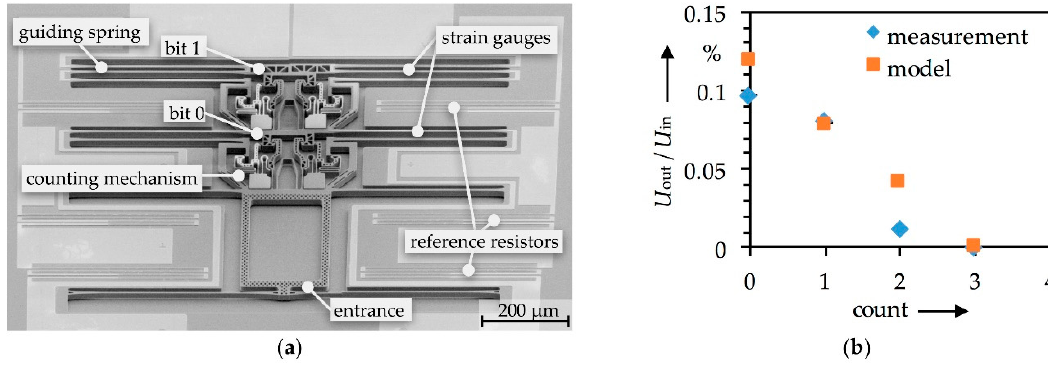
Figure 4. MEMS-DAC: ( a ) SEM image of a fabricated 2-bit binary counter with MEMS-DAC realized with strain gauges in a quarter bridge; ( b ) Measurement results of the